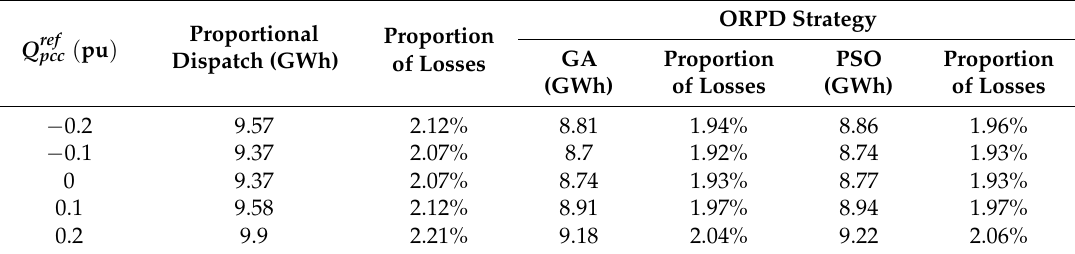
Table 2. Total annual losses.